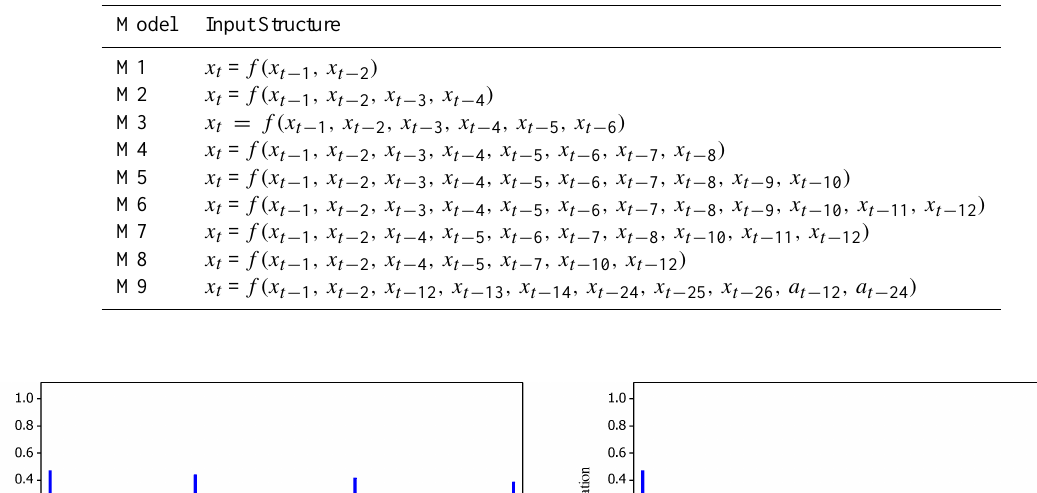
Table 3. The Input Structure of the Models for Forecasting of Bernam River Flow.